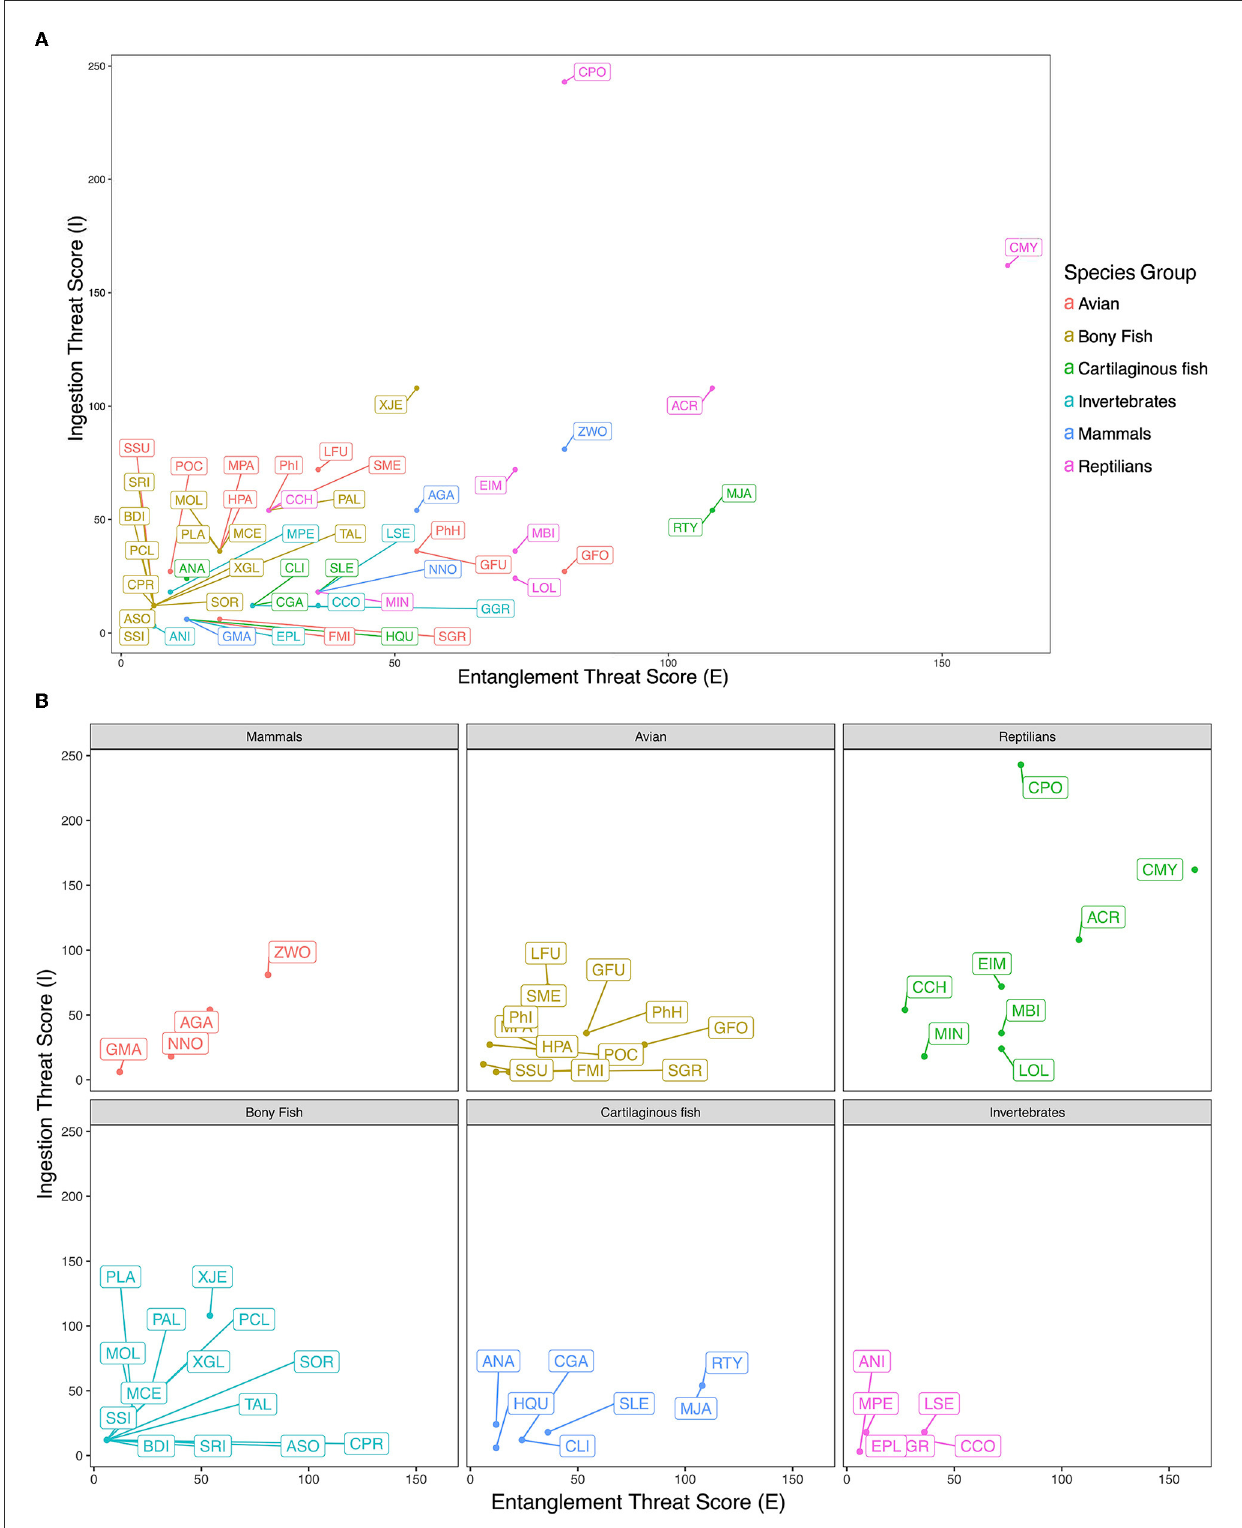
FIGURE5 (A) Calculated plastic pollution threat scores for the 52 species evaluated in this study. Entanglement Threat Score (E); Ingestion Threat Score (I). AVIAN: *Medium ground Finch (G. fortis) GFO*; *Lava gull ( L. fuliginosus ) LFU*; *Flightless cormorant ( P. harrisi ) PhH*; Small ground Finch ( Geospiza fuliginosa ) GFU; Waved Albatross ( Phoebastria irrorata ) PhI; Galápagos penguin ( Spheniscus mendiculus ) SME; Oyster catcher ( Haematopus palliatus galapagoensis ) HPA; Galápagos mockingbird (Mimus parvulus) MPA; Brown pelican ( Pelecanus occidentalis urinator ) POC; Nazca Booby ( Sula granti ) SGR; Red-Footed Booby ( Sula Sula ) SSU; Great frigatebird ( Fregata minor ) FMI. BONY FISH: *Black-striped salema ( X. jessiae ) XJE *; *Whitespotted sandbass ( Paralabrax albomaculatus ) PAL*; Flathead Mullet ( Mugil cephalus ) MCE; Bacalao grouper ( Mycteroperca olfax ) MOL; Razor surgeon